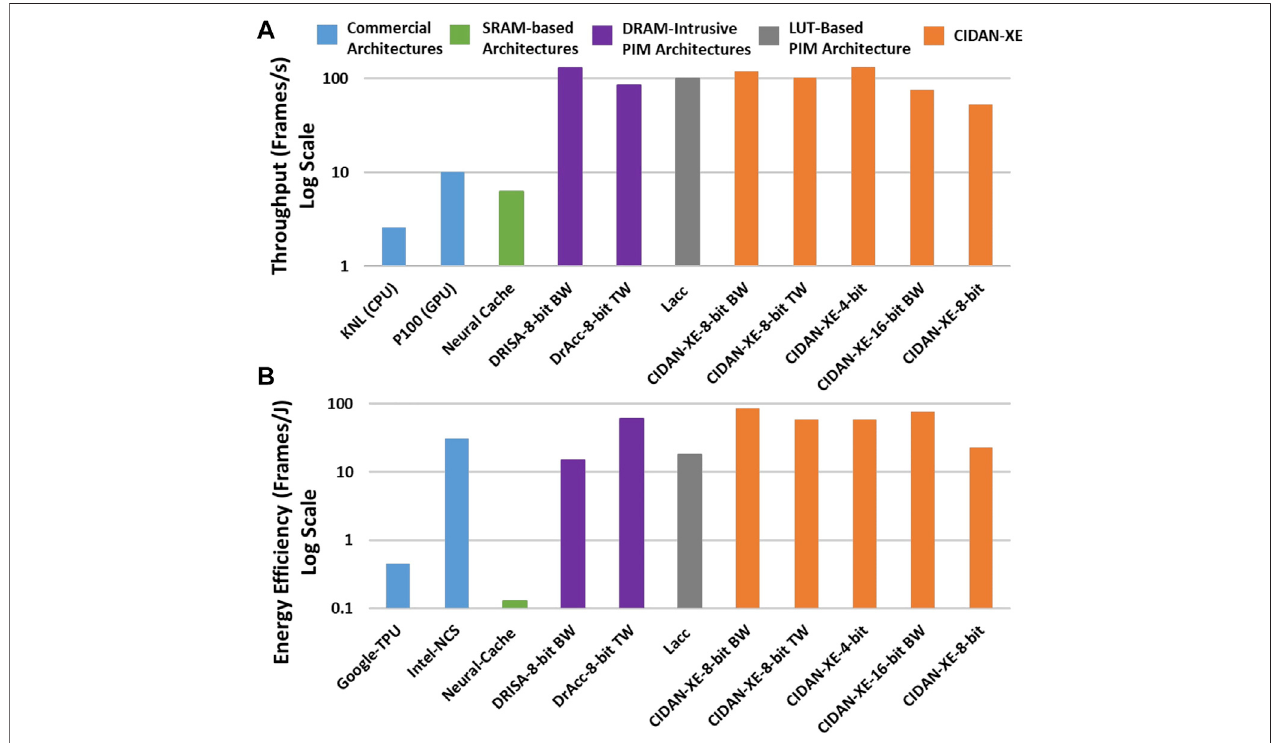
FIGURE 13 | Throughput (A) and energy-ef fi ciency (B) comparison of CIDAN-XE against the state of the art architectures when computing ALEXNET.